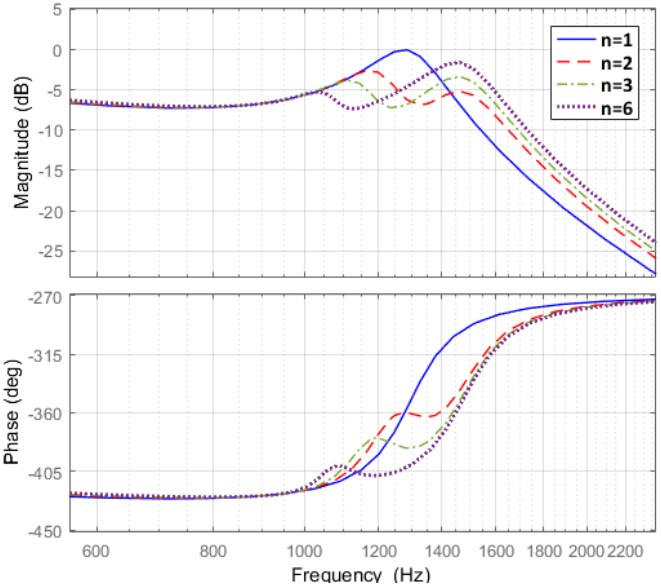
Figure 6. The Bode diagram of Φ O_m with difference n.